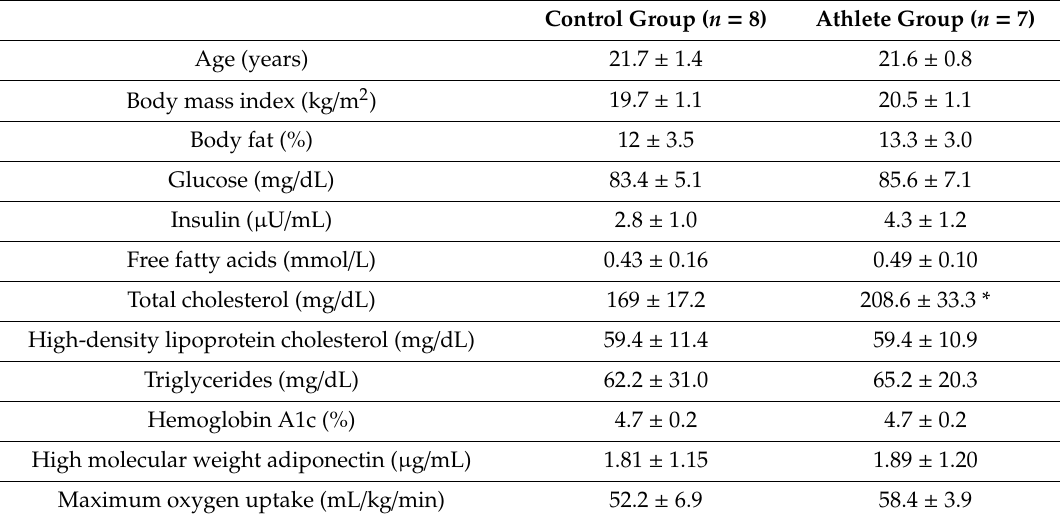
Table 1. Characteristics of the control and athlete groups.